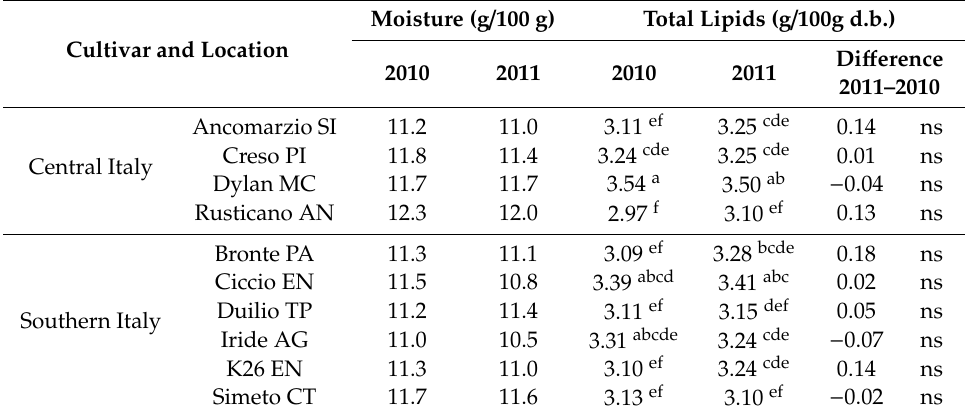
Table 2. Moisture and total lipids in the grains of 10 Italian durum wheat cultivars grown in di ff erent locations for two consecutive